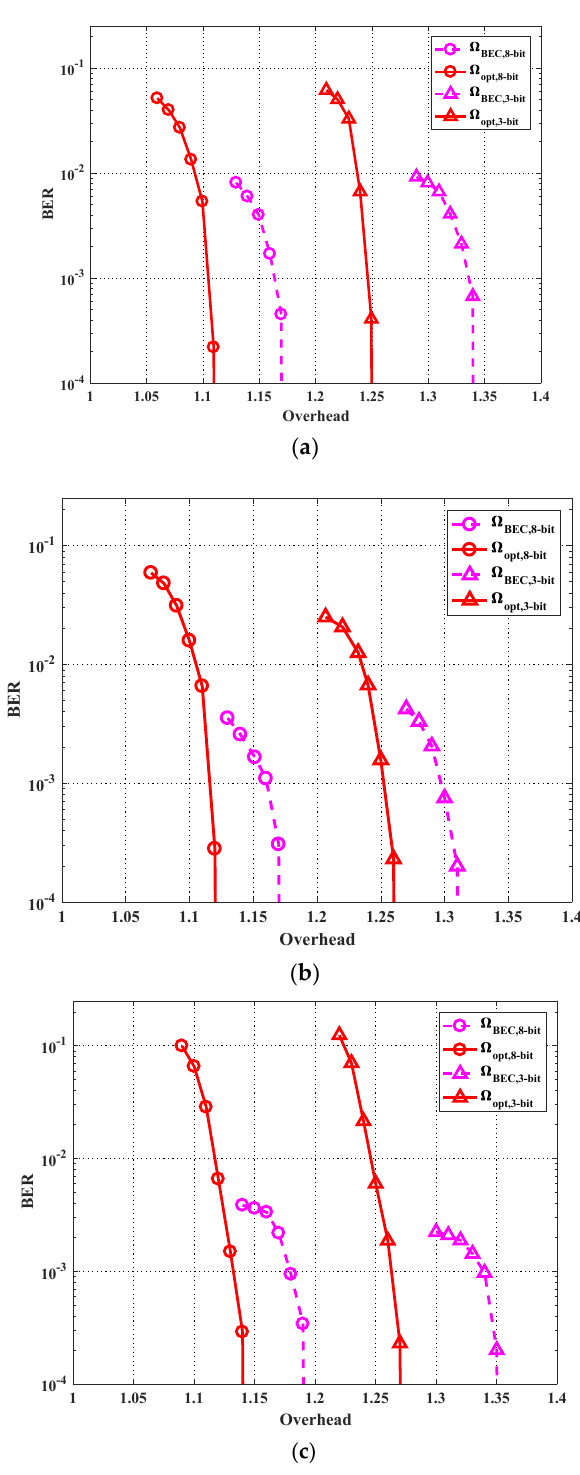
Figure 7. Bit error rate (BER) performance with the optimized profiles and benchmark profile for the cases of the three-bit quantizer and the eight-bit quantizer under different channel matrices: ( a ) 𝐇 1 , ( b ) 𝐇 2 , and ( c ) 𝐇 3 . (2) Throughout